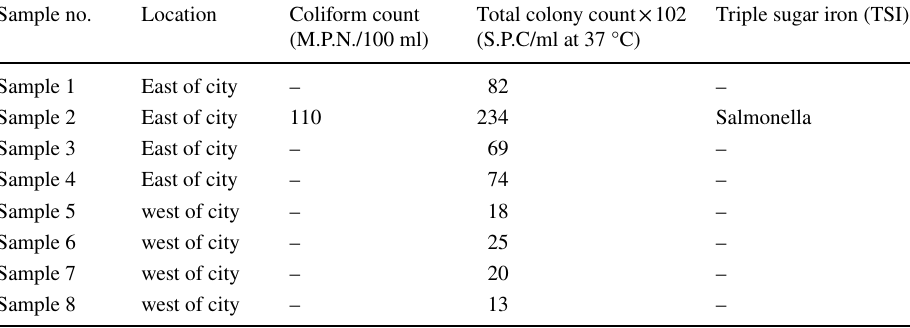
Table 9 Bacteriological analysis of well samples in the 10th of Ramadan city. (After El Sayed et al.